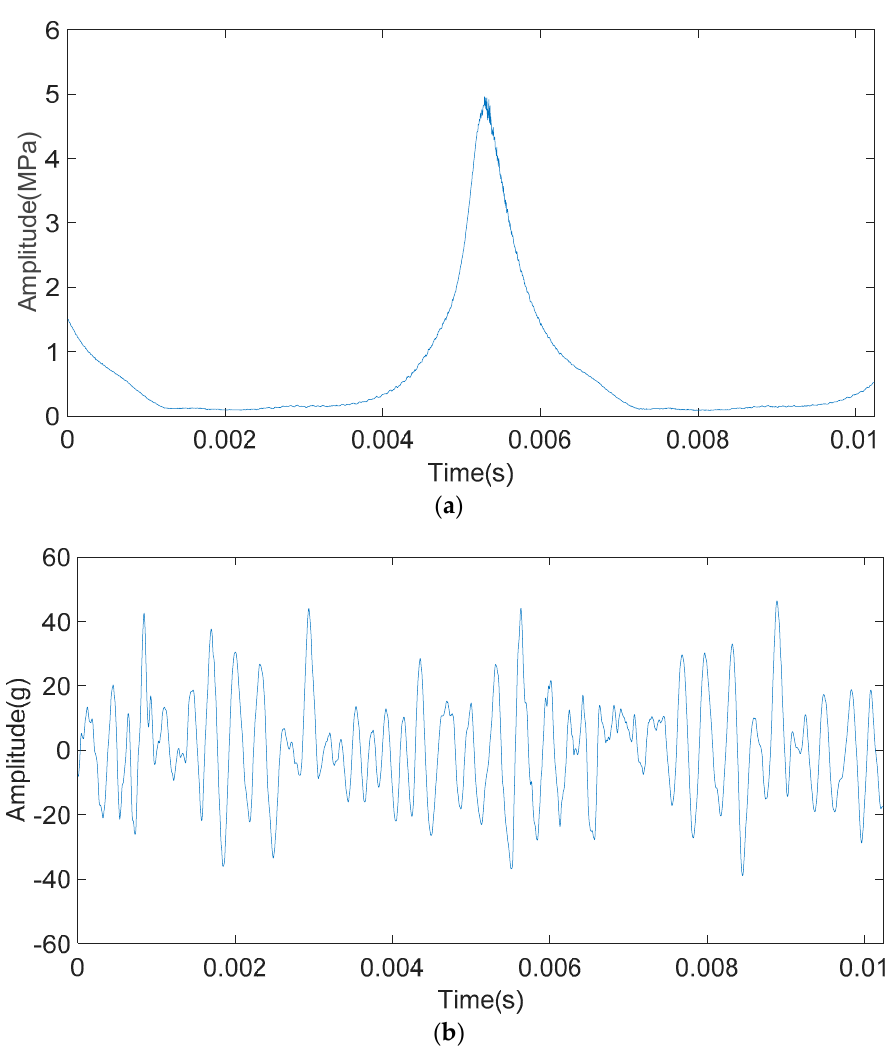
Figure 11. Time-domain waveform of the cylinder pressure signal and the engine block vibration signal under a weak knock condition at 5100 rpm. ( a ) Time-domain waveform of the cylinder pressure signal under a weak knock condition at 5100 rpm. ( b ) Time-domain waveform of the engine block vibration signal under a weak knock condition at 5100 rpm.